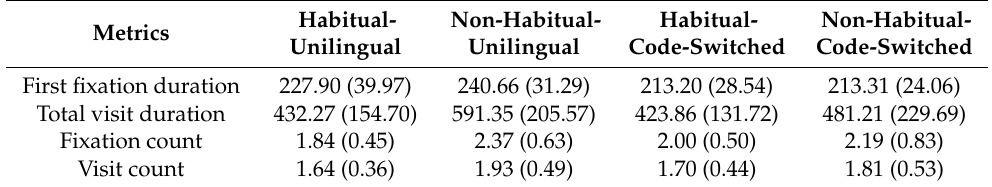
Table 4. Table of the mean and standard deviations (in brackets) of the different metrics